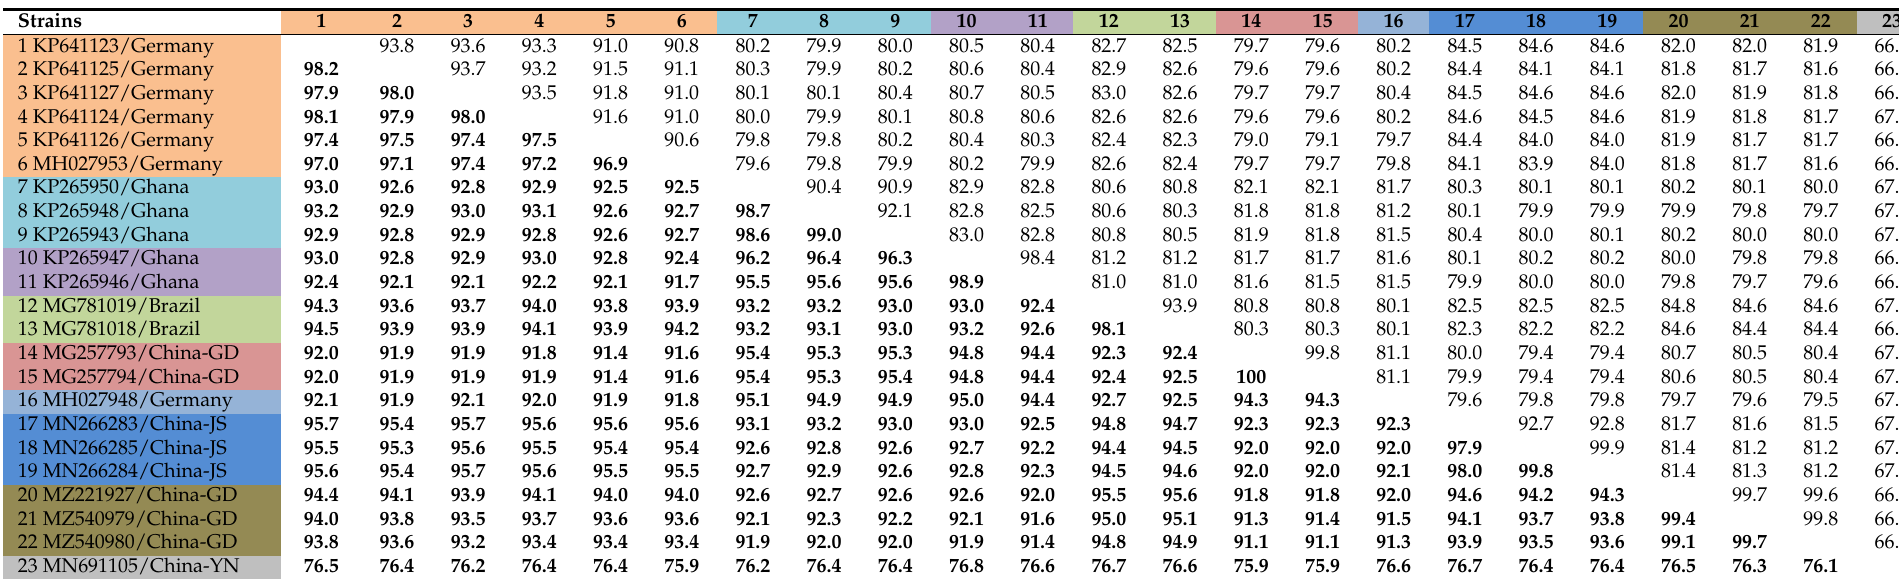
Table 2. The sequence identity within the BovHepV polyprotein gene at the nucleotide (upper right) and amino acid (lower left, boldface) levels calculated using ClustalW method implemented in MegAlign. The compared strains were indicated as accession number and country, and the different colors mean the different subtypes/genotypes of the BovHepV strains.